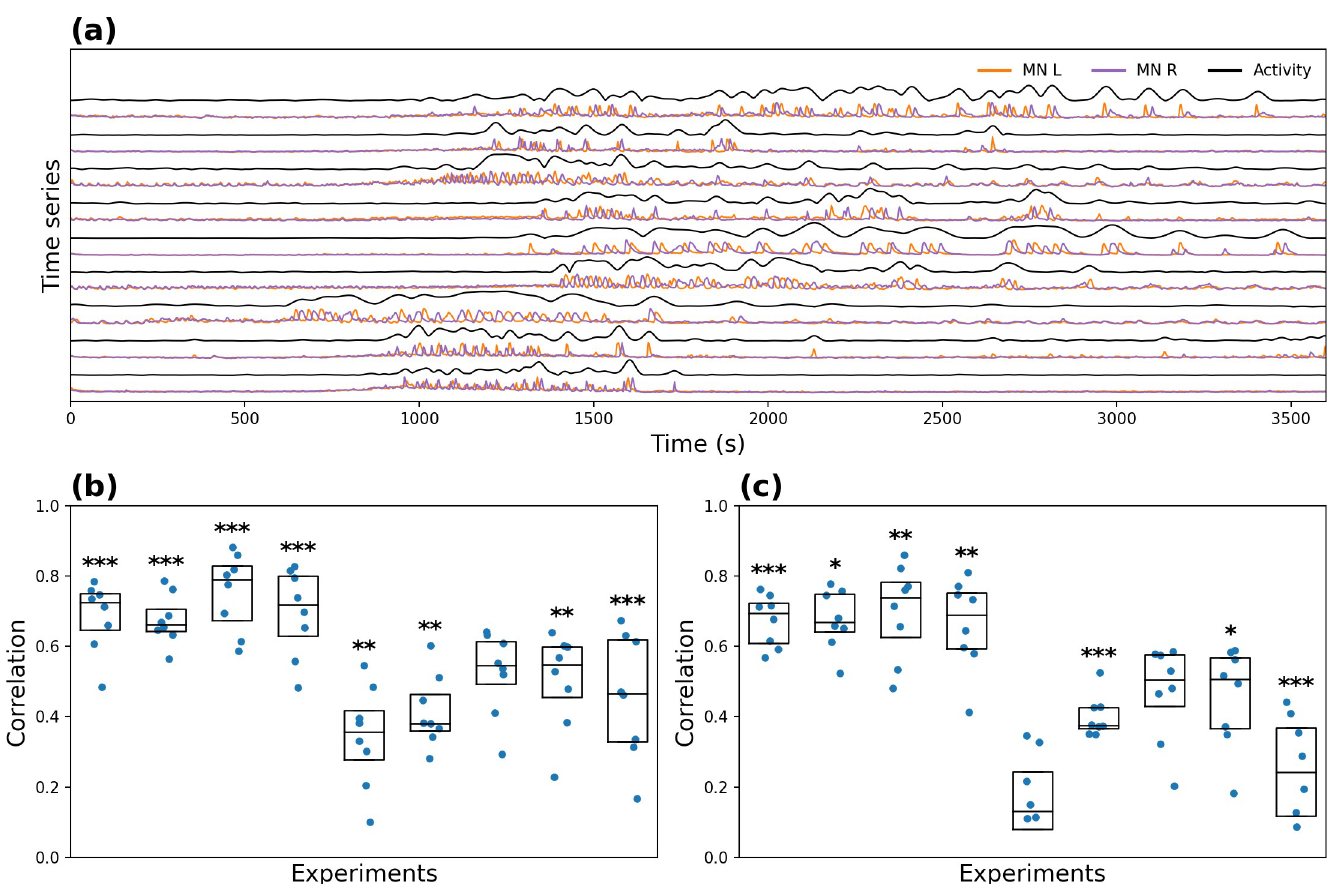
Fig 5. Correlation between α CCAP neuron and motoneuron activity. (a) Orange and purple lines show the activity of the left (“MN L”) and right (“MN R”) motoneuron regions, respectively, and the black line (labeled “Activity”) shows the amplitude of the motoneuron signal. (b) Correlation coefficients between α CCAP neurons and the amplitude of the motoneuronal time series, with individual data as points and boxes indicating median and quartiles. (c) Analogous to (b) , but with the pre-ecdysis phase removed. Significance of the within-experiment correlations was tested using a one-tailed Mann-Whitney U test comparing to null cross- experiment correlations � : p-value < 0.05, �� : p-value < 0.01, ��� : p-value < 0.001.